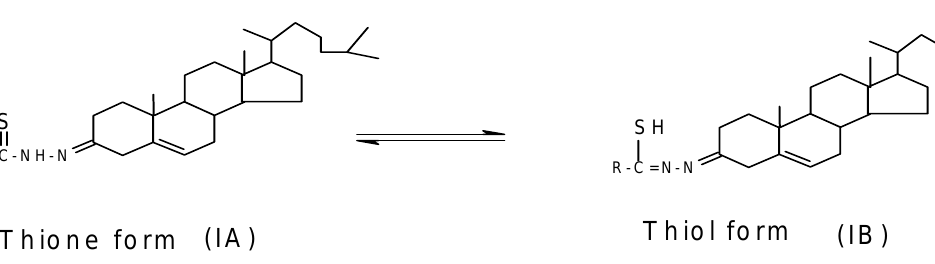
Figure 1. Structure of thione and thiol form of thiosemicarbazones.